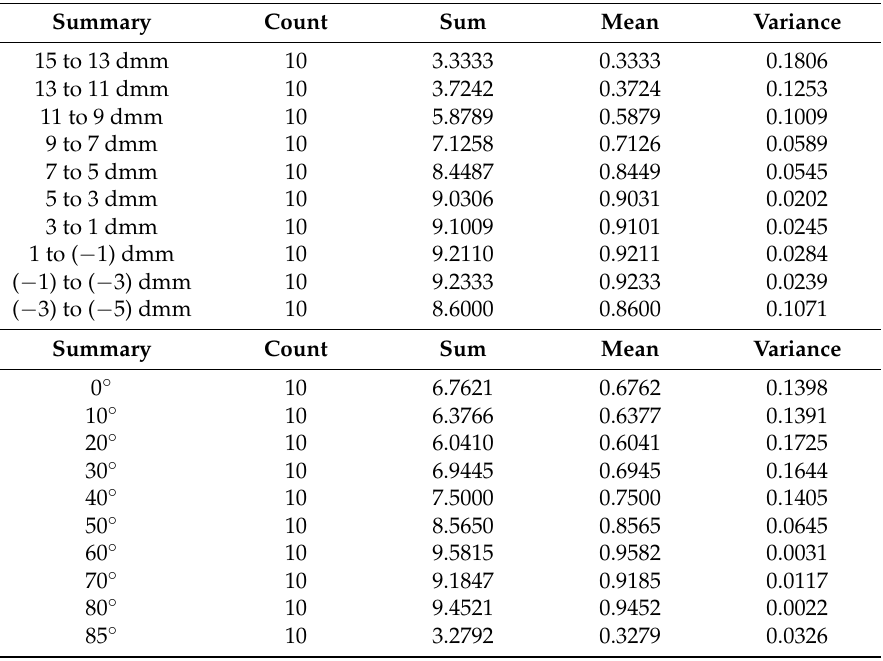
Table 1. Analysis of variance of two factors without replication. Factor 1: the difference between the rootstock and scion diameters, where the positive values represent a larger diameter of the rootstock and the negative ones a larger diameter of the scion. Factor 2: cutting angles of the